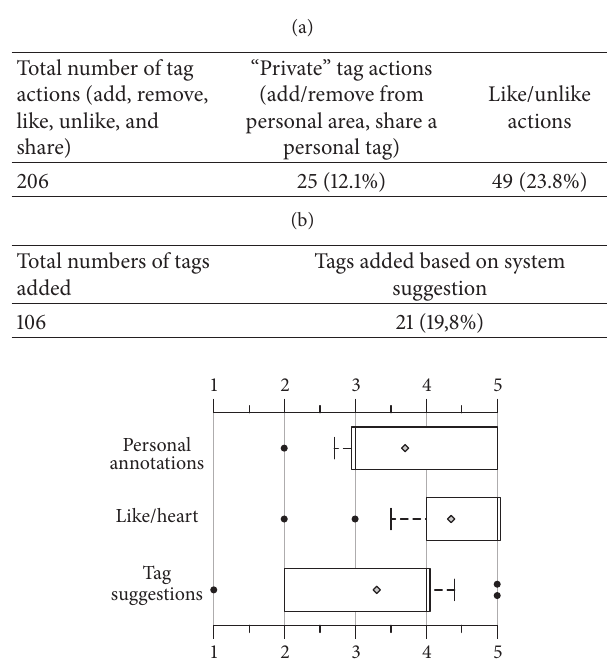
Table 1: Summary of data on application usage logged during the evaluation.